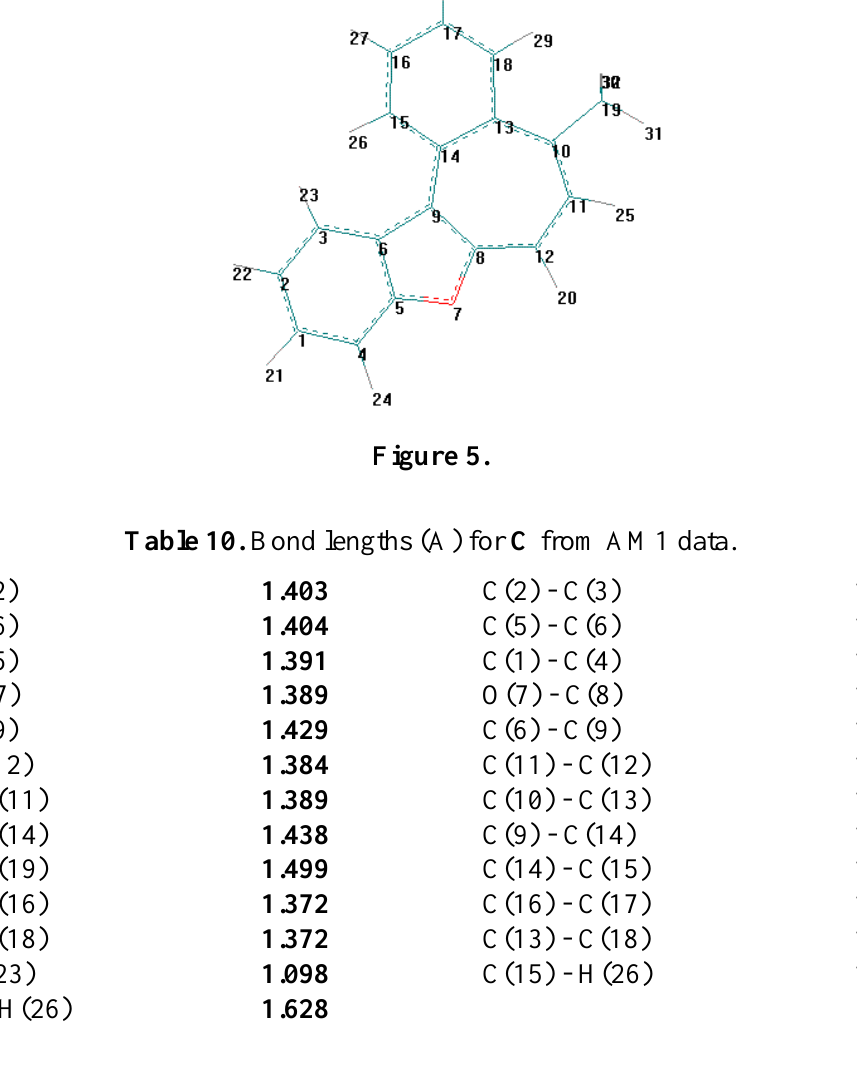
Table 11. Bond angles (deg). For C from AM1 calculation